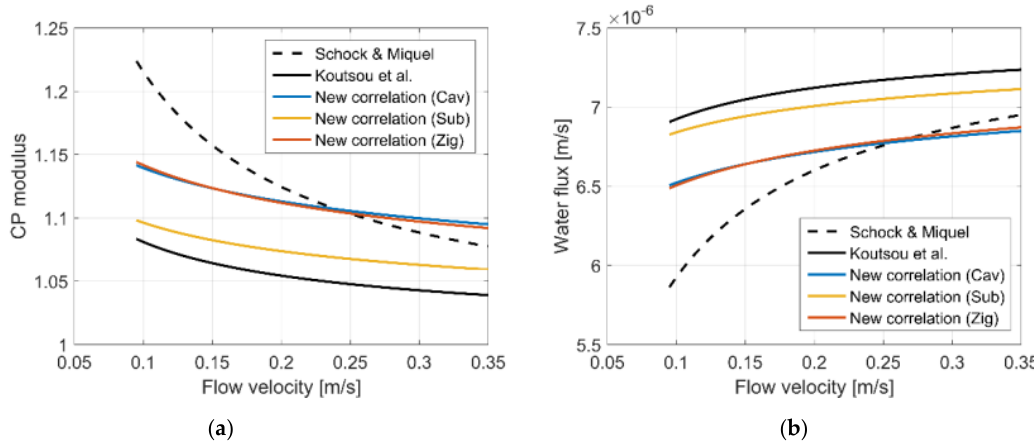
Figure 6. Comparisons of CP modulus and water flux calculated by different correlations: Sherwood number correlations of Schock and Miquel [30] and Koutsou et al. [27] expressed in Equations (20) and (21), respectively, and our new correlations. ( a ) CP modulus and ( b ) water flux.